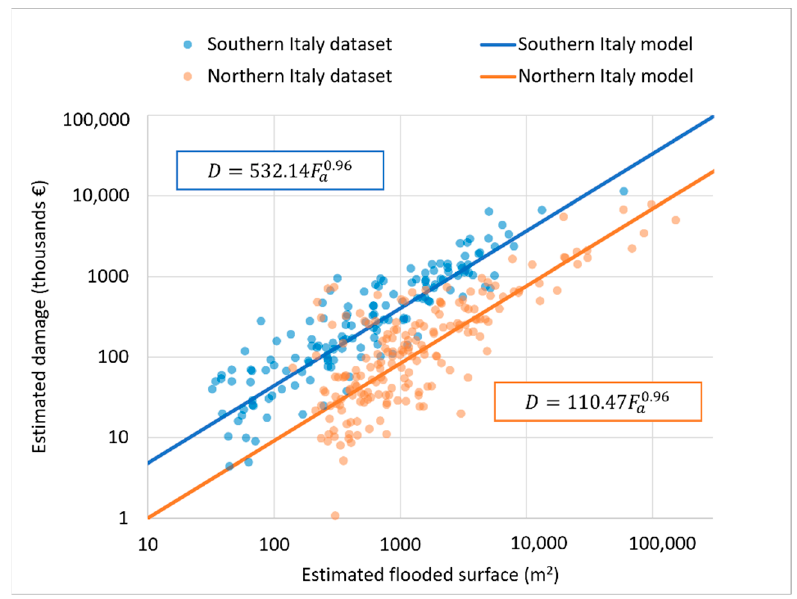
Figure 10. Comparison between the two datasets and models obtained for Northern and Southern Italy. Table 4. Model power-law parameters.